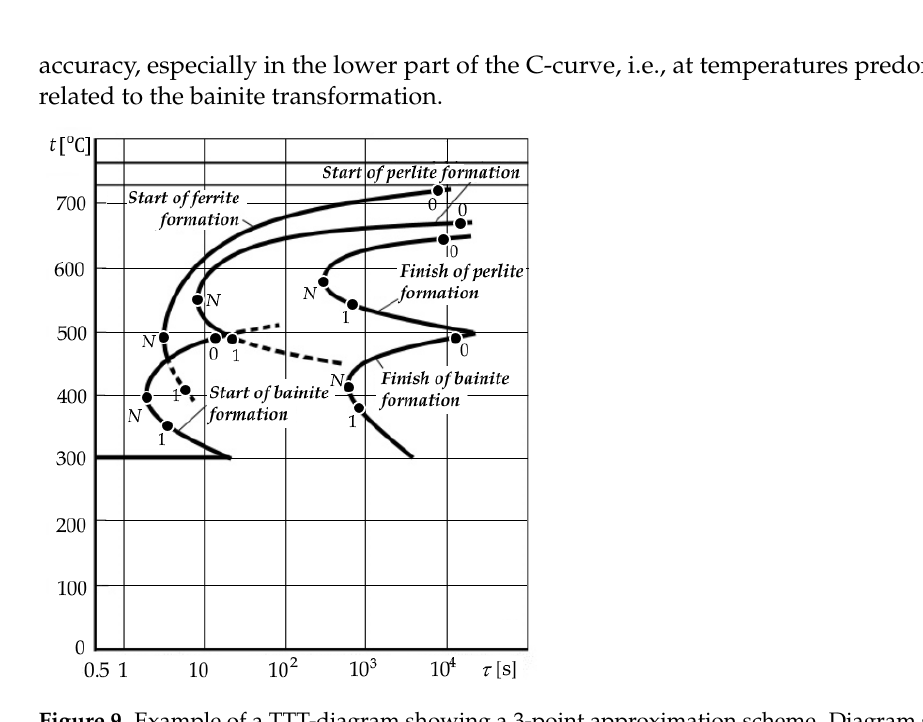
Figure 9. Example of a TTT-diagram showing a 3-point approximation scheme. Diagram shows the reference points taken in the approximation for each C-curve: 0 — upper, N —“ nose ” , 1 — lower.